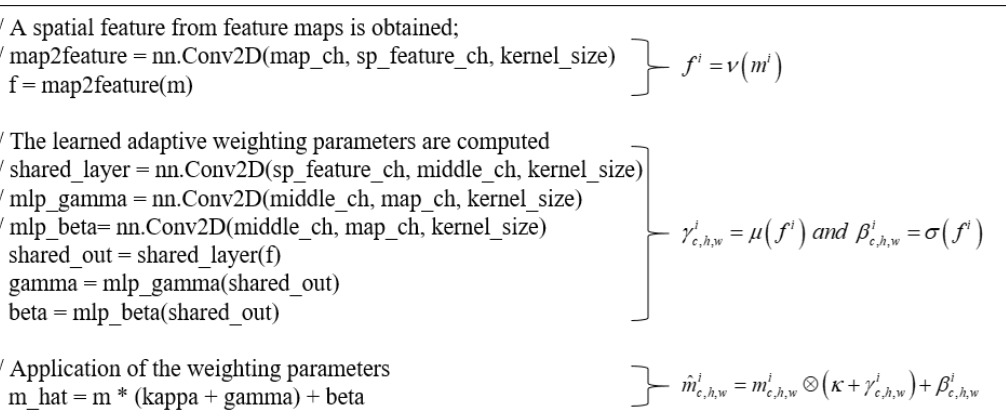
Figure 2. A pseudo-code of the proposed self-spatial adaptive weighing structure.